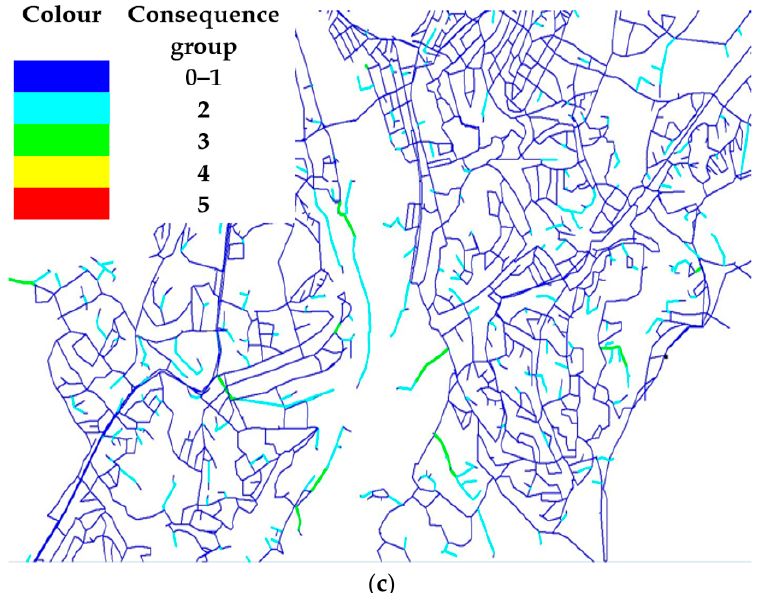
Figure 6. Classification of pipes for an excerpt of Trondheim WDN according to C values in different service scenarios with supply from ( a ) J, ( b ) B, and ( c ) JB.